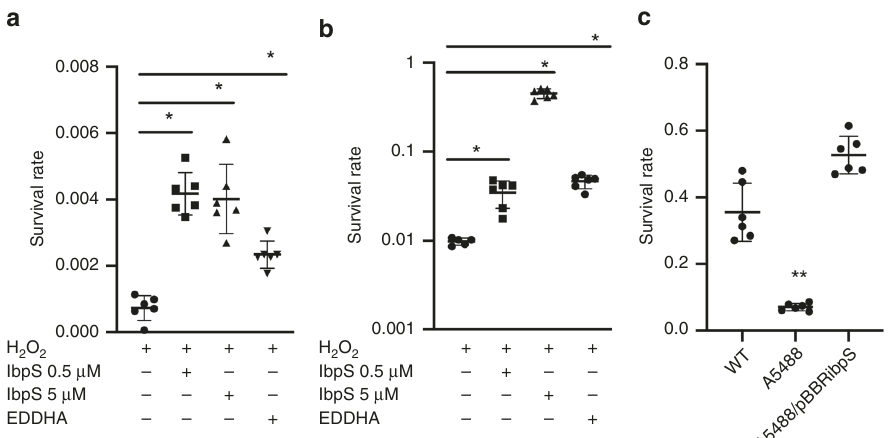
Fig. 8 IbpS protects bacteria exposed to hydrogen peroxide. a D. dadantii A4922 or b E. coli NM522 cells were resuspended in water either supplemented or not with 0.5 or 5 µ M IbpS or 5 µ M EDDHA. After 5 min, 5 m M ( a ) or 20 m M ( b ) H 2 O 2 was added. After 30 min, the number of viable bacteria was determined by plating serial dilutions on LB agar plates. c The D. dadantii A4922 wild-type strain (WT), the ibpS mutant and the complemented ibpS / pBBR ibpS strain were grown overnight in Tris medium plus glycerol containing chicory pieces to an OD = 1 and treated in the conditioned medium with 20 m M H 2 O 2 for 1 hour. Viable bacteria number was determined by plating serial dilutions on LB agar plates. Mean ( n = 6) and SD are represented on the dot plot graph. * denotes signi fi cant differences; p < 0.005, two-sided Mann and Whitney test. Source data are provided as a Source Data fi